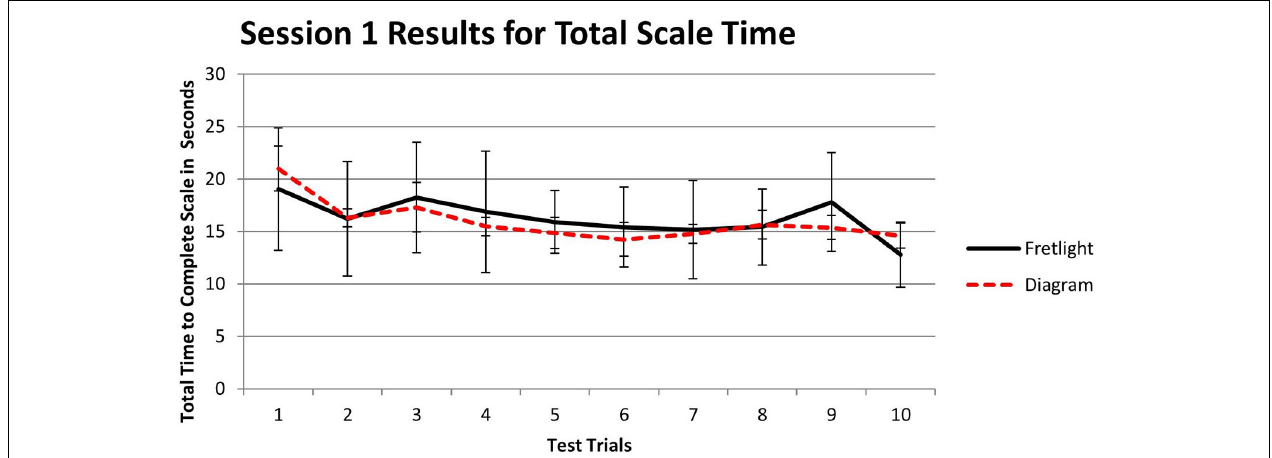
FIGURE 11 | Time to complete each immediate test trial by learning method.